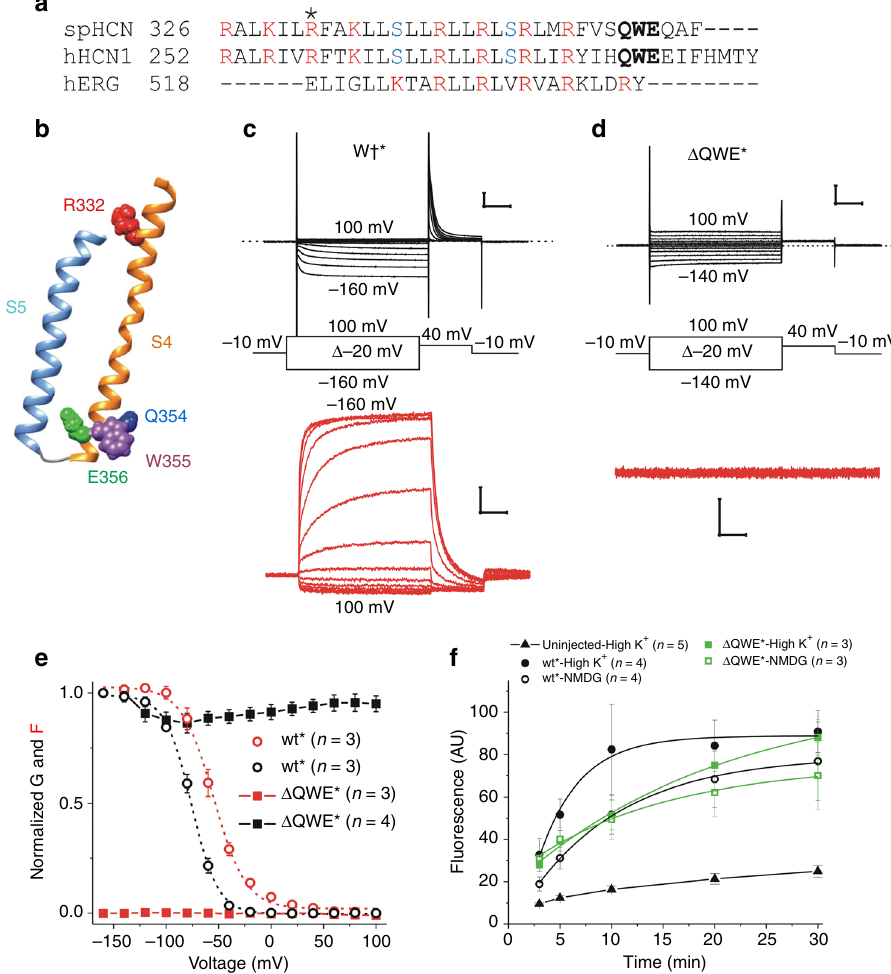
Fig. 1 Deleting QWE at the C-terminal S4 leads to an always open channel with an immobilized S4. a S4 sequence alignment of spHCN, hHCN1, and hERG channels. The conserved QWE sequence is shown in bold. R332 is shown with an *. b spHCN homology model showing the position of the QWE residues. c , Representative traces of the current (black) and fl uorescence (red) from c wt* and d Δ QWE * channels. Scale bars: 0.1 s, 5 µ A, and 2% Δ F/F . e Normalized G(V) (black) and F(V) (red) curves of wt * and Δ QWE * channels. f Tetramethyl-rhodamine C5-maleimide labeling of uninjected oocytes and oocytes expressing the R332C (wt) and R332C/ Δ QWE ( Δ QWE) channels in high K + and NMDG solutions. Labeling rates ( k ): 0.25 ± 0.06 (wt in high K + ), 0.11 ± 0.01 ( p = 0.05) (wt in NMDG), 0.05 ± 0.01 ( p = 0.01) ( Δ QWE in high K + ), 0.07 ± 0.02 ( p = 0.001) ( Δ QWE in NMDG). Mean ± SEM. p values indicate statistical difference from wt in high K + solution. Source data are provided as a Source Data fi